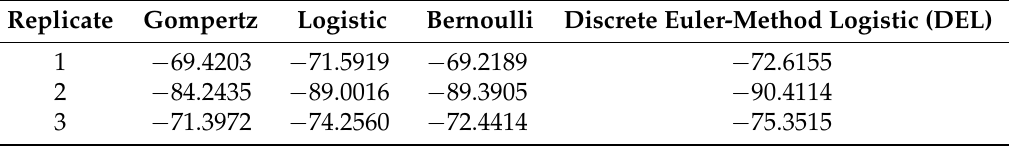
Table 1. Corrected Akaike Information Criterion scores for each model and replicate.